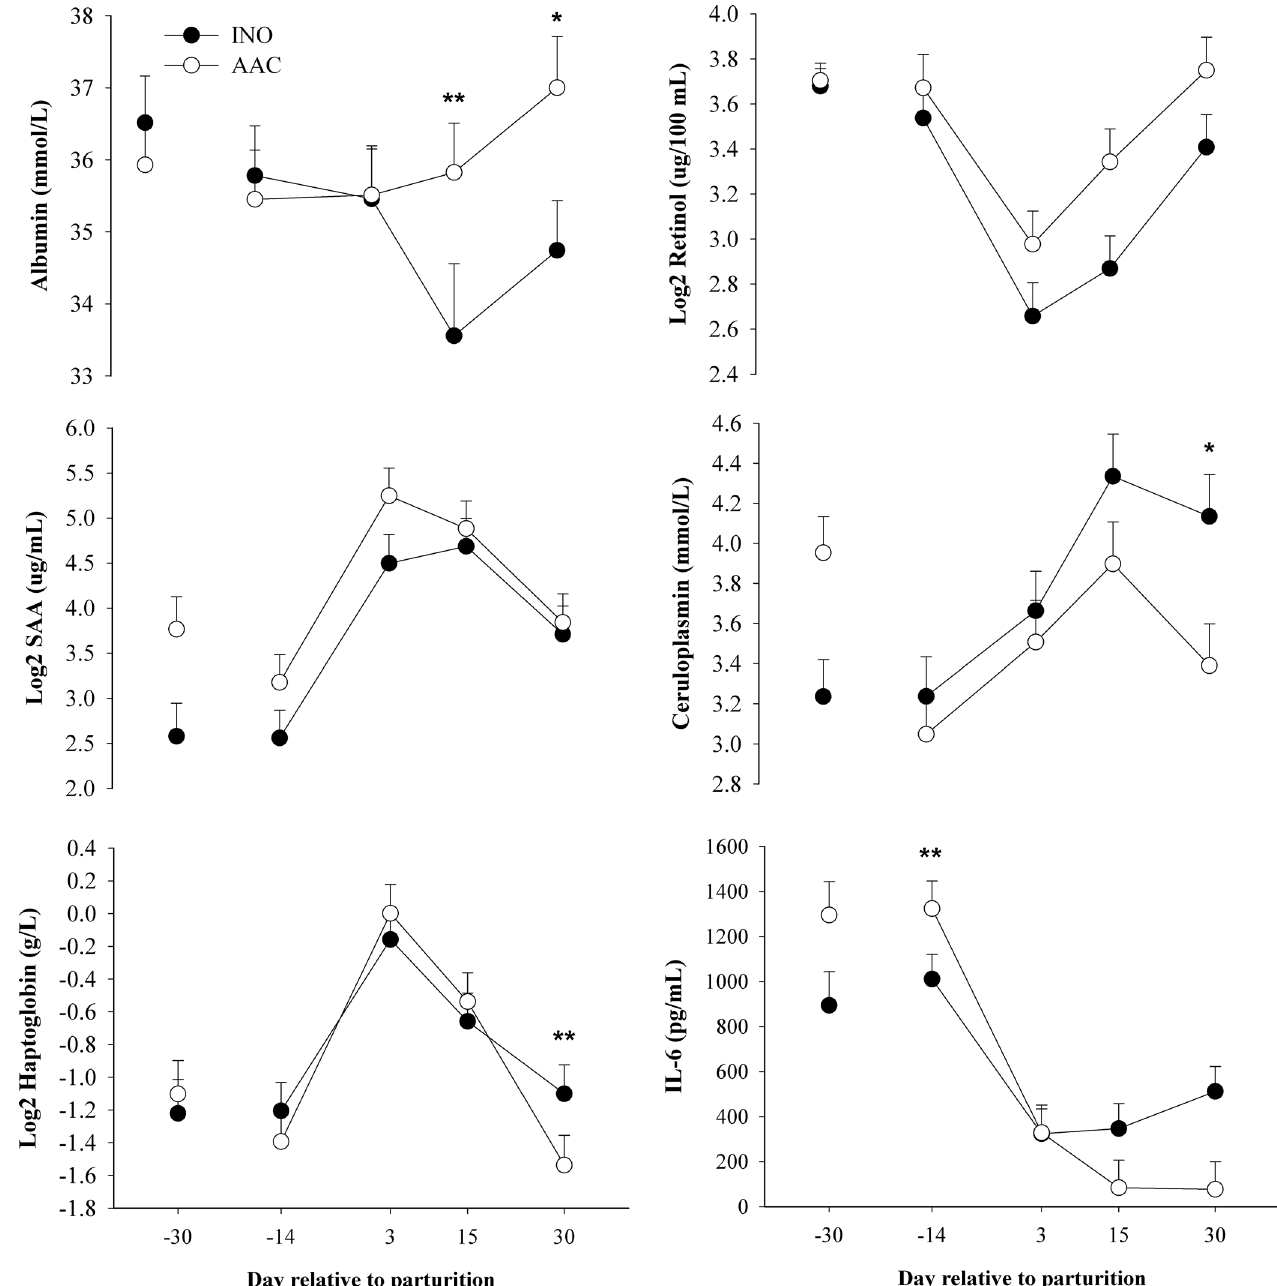
Fig 2. Effects of supplementing cows with inorganic (INO; n = 11) or organic (AAC; n = 9) trace minerals during the pre and postpartal periods on blood biomarkers of inflammation. Mean separations between diets at a given time point were evaluated when a D × T effect ( P (cid:2) 0.10) was observed. Differences ( * ) were declared at P (cid:2) 0.05 and trends ( ** ) at P (cid:2)